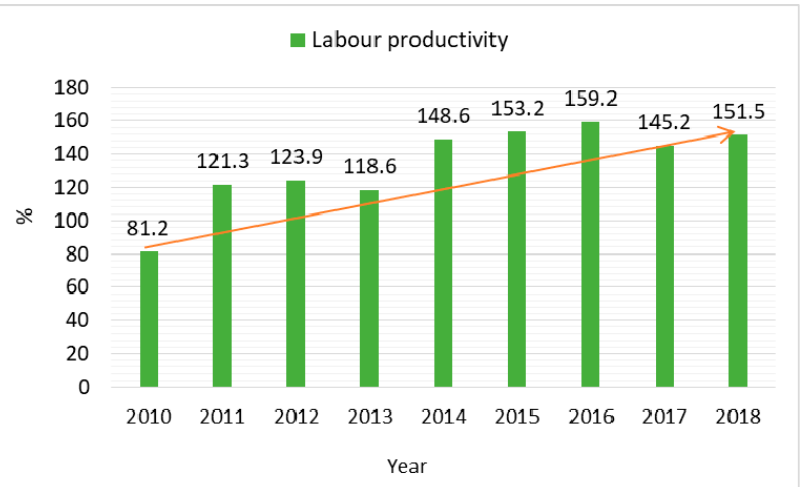
Figure 3. Labour productivity in industry measured by the gross value added in Poland. Description: line in red colour—increase of labour productivity. Source: Data from GUS [122].